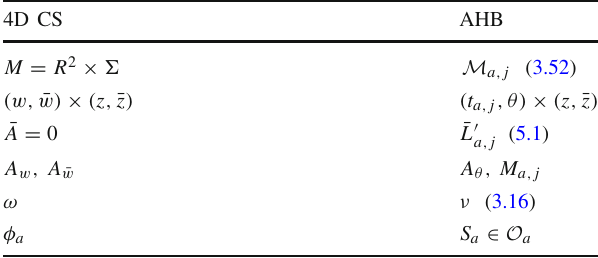
Table 4 Correspondence between fields 4D CS